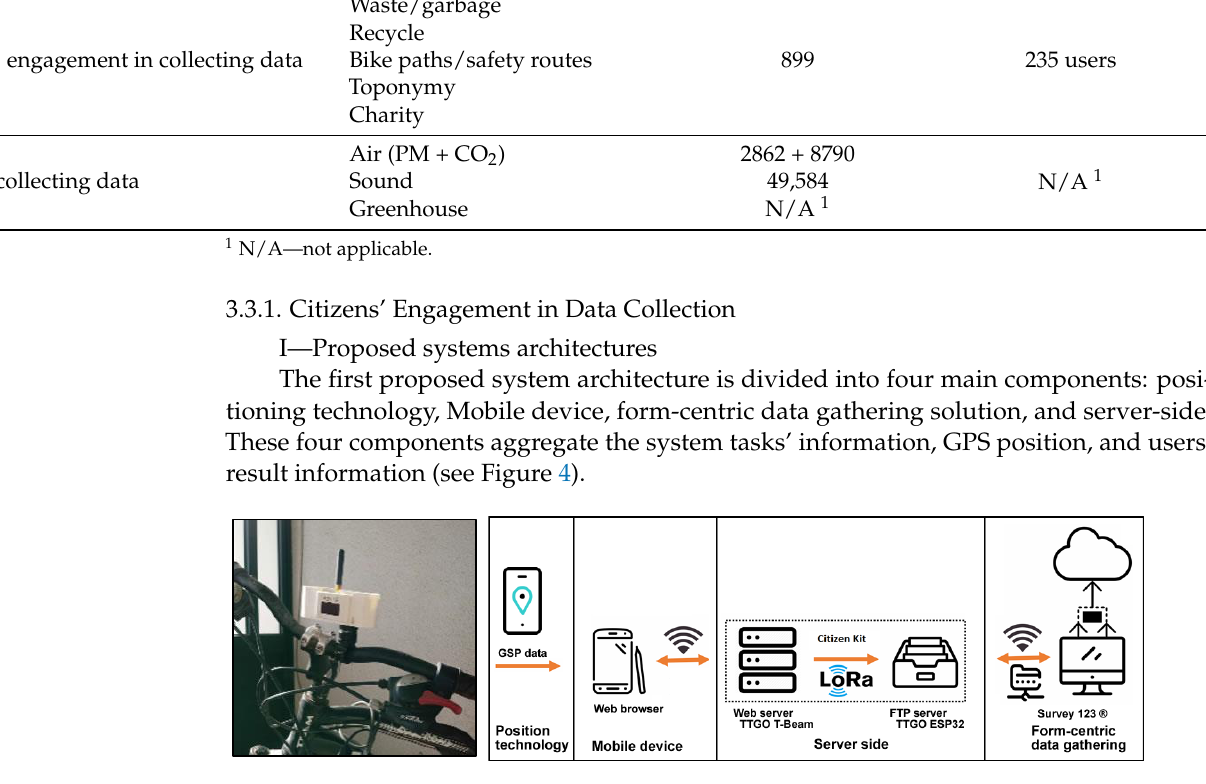
Figure 4. First proposed system architecture.